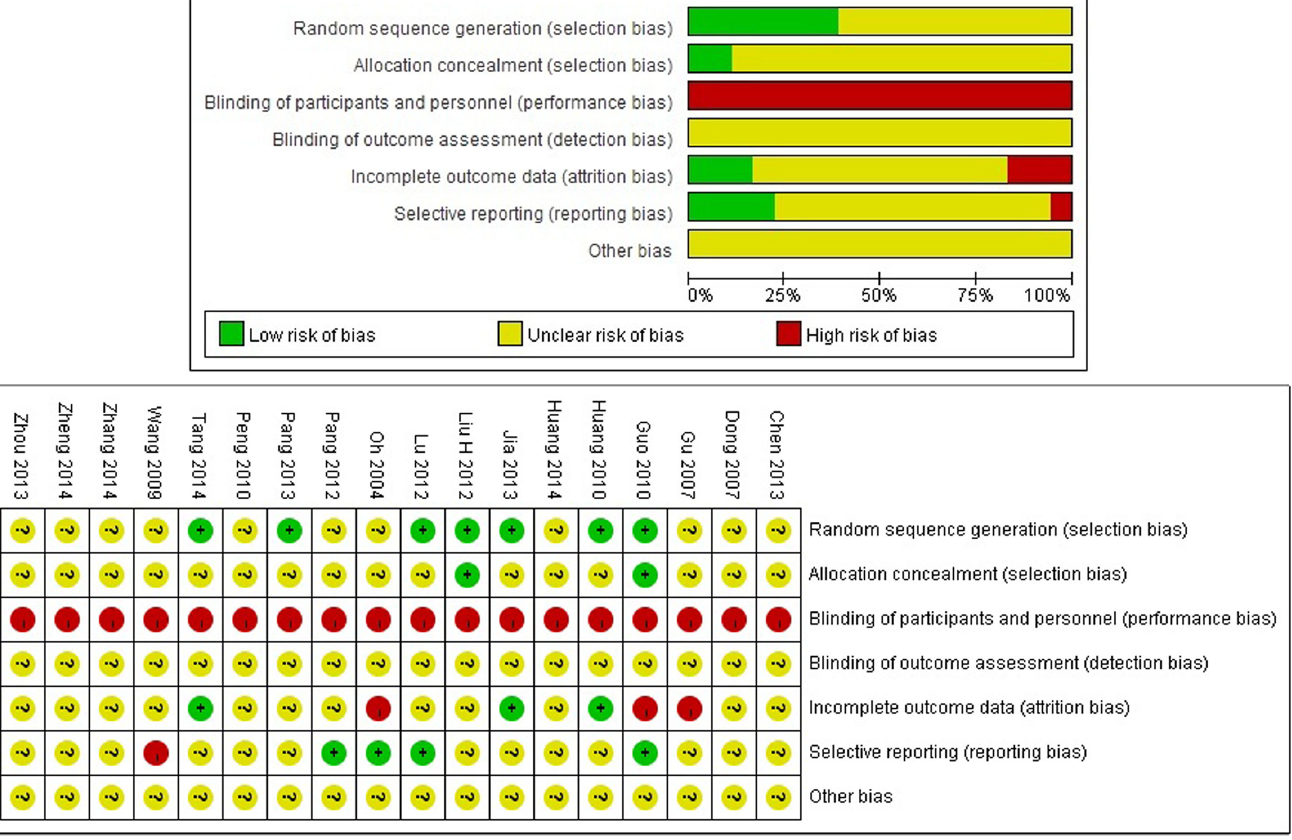
Fig 2. Summary of the Risk of bias assessment for each included